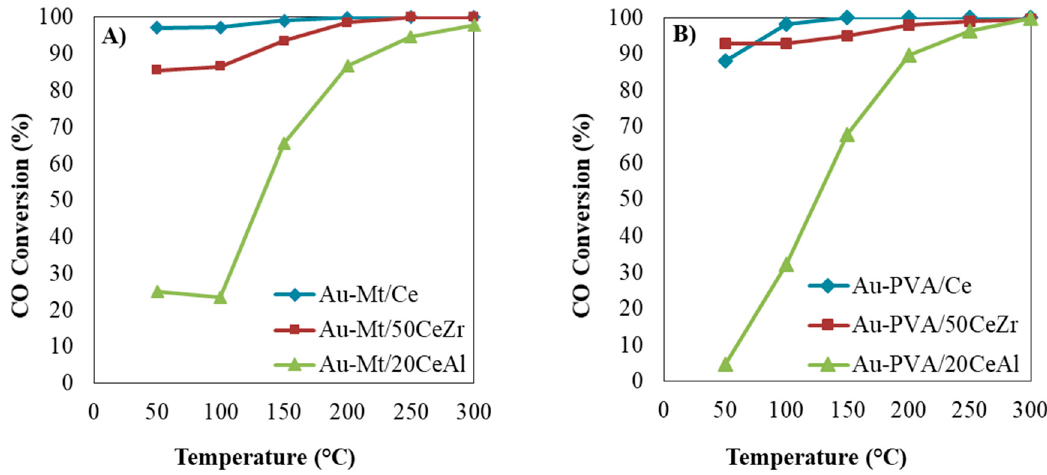
Figure 3. CO conversion (%) over ( A ) Mt-solids and ( B ) PVA-solids.